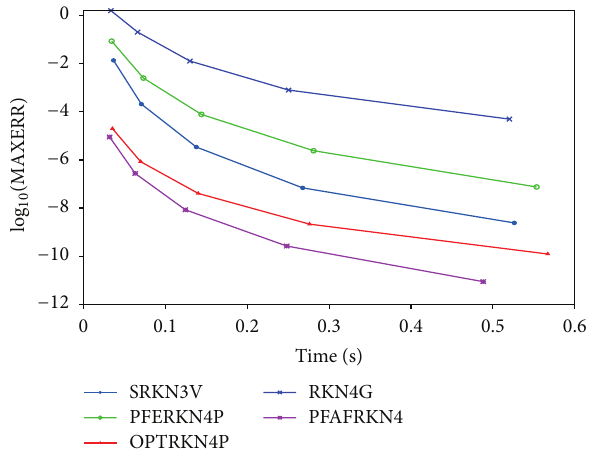
Figure 5: Efficiency curves for all methods for Problem 2 with ℎ = 1/2 𝑖 , 𝑖 = 4, ...,8